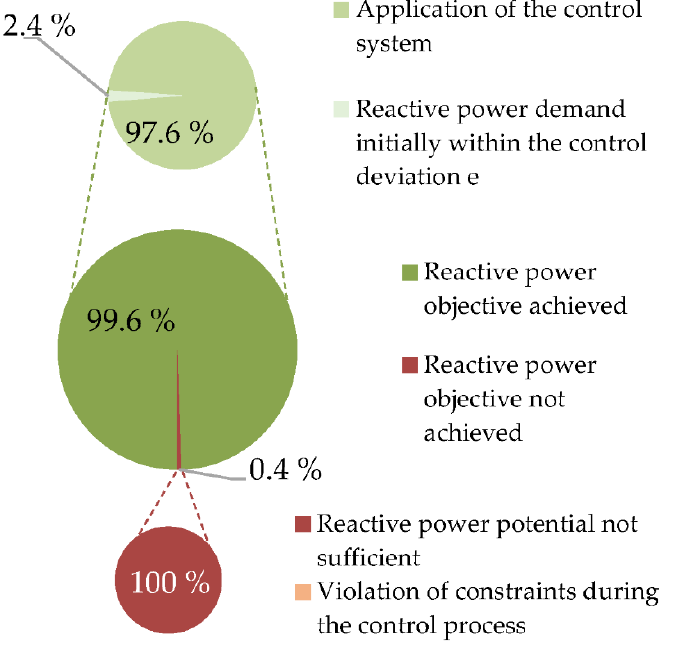
Figure 10. Root cause analysis for achieving or missing the objective of full compensation (with tolerable control deviation e).